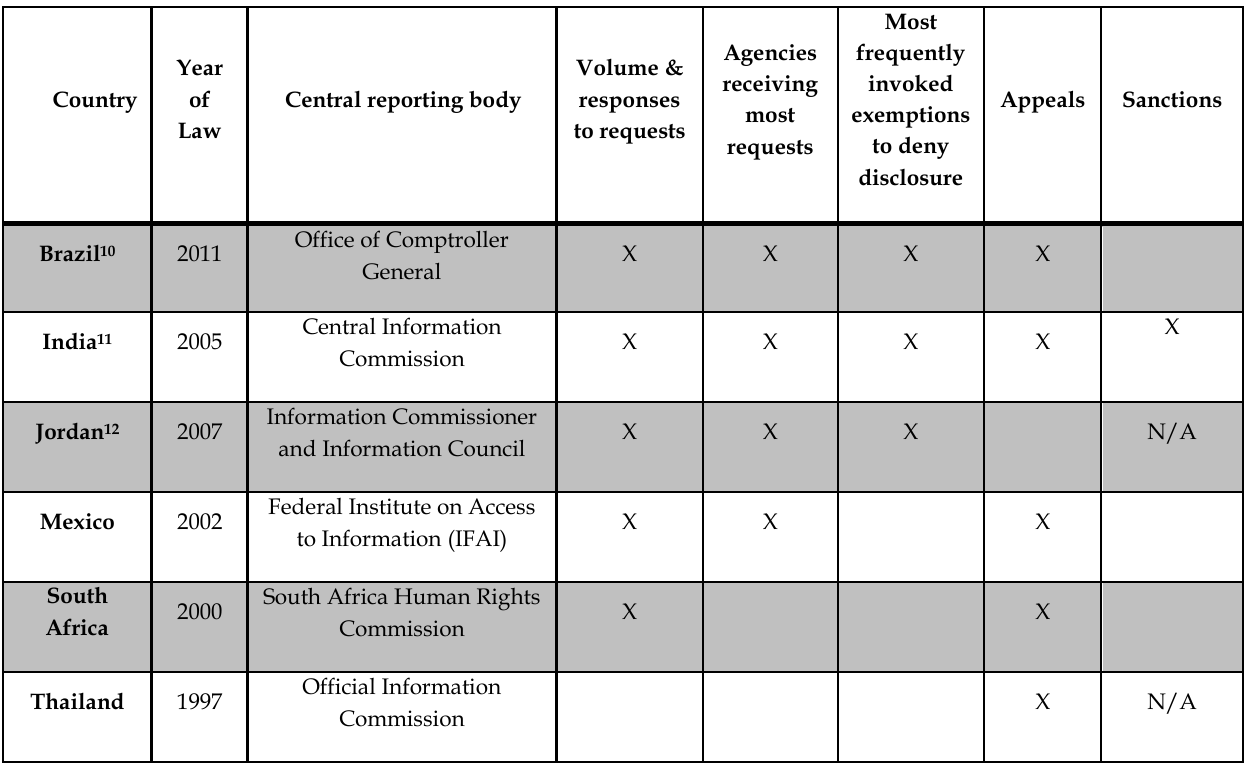
Table 1: Summary of Available